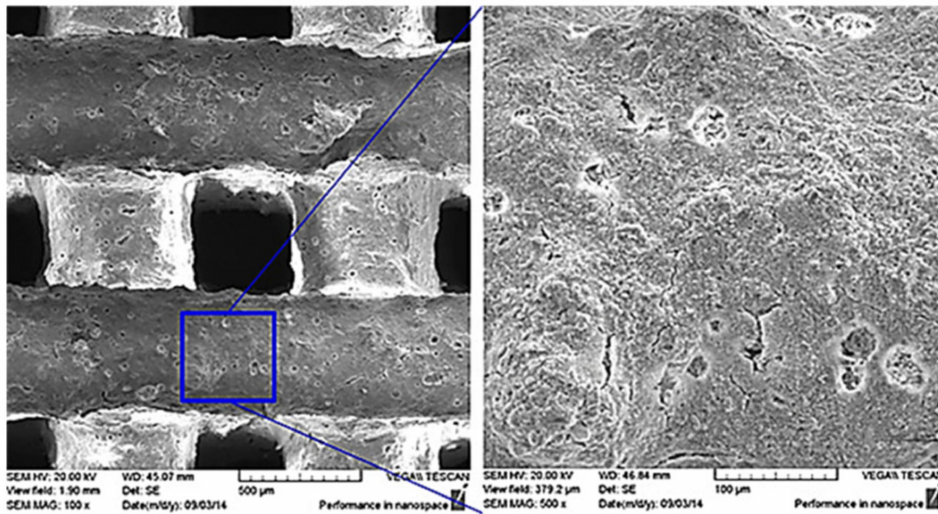
Figure 10. SEM images of the BCP/zirconia scaffold. The left image shows a pore size of approx- imately 350 µ m and printed lattice width of 500 µ m. The right side depicts a granular surface of the 3D-printed scaffold after printing and sintering. Images used from Sa et al. [81] reprinted with permission from Willey and sons, copyright©